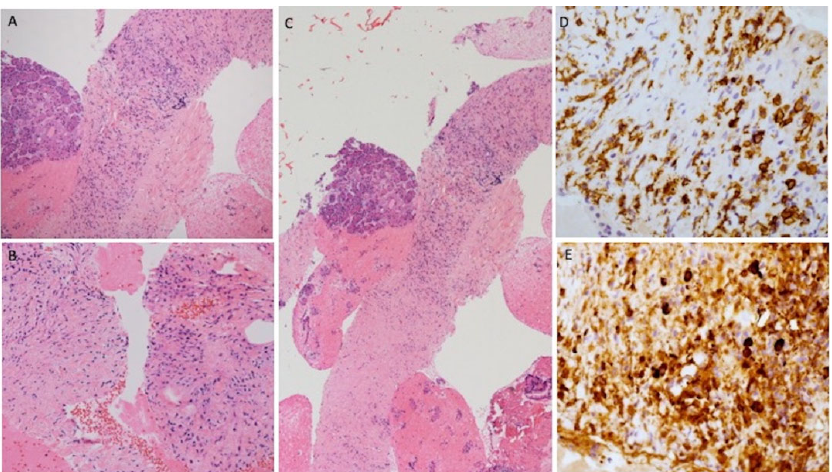
Figure 2. The histological examination demonstrated fragments of sclerotic stroma in storiform fashion, in which inflammation cells (most lymphocyte and plasma cells) were recognizable (( A – C ); Hematoxylin and Eosin stains at different magnifications). Moreover, the immunostaining for CD38 highlighted the plasma cells population ( D ) and immunostaining for IgG4 showed a considerable amount of specific immunoglobulin in diagnostic range for type 1 autoimmune pancreatitis ( E ). The CMFP represents the 10–30% of chronic pancreatitis and the differential diagnosis with pancreatic cancer is very difficult [2]. MRI has a high diagnostic accuracy in the diagnosis of chronic pancreatitis with a sensitivity and specificity, respectively, of 78% and 96% [3]. Gu et al. suggest using 18F-FDG PET/CT combined with CA19–9 to differentially diagnose pancreatic cancer from CMFP [4]. EUS is a very sensitive examination to detect pancreatic masses and can provide useful information in cases where conventional radiologic workup remains inconclusive [5]. Thanks to its high-resolution images, EUS is more precise than MRI and CT for the diagnosis of small pancreatic lesions. However, its specificity remains low (about 50%) since most lesions showed unclear echoic signs. Probably, the association of EUS with contrast enhancement and elastography can increase the overall accuracy [6,7]. Choline plays an important role in the structure and the function of biological membranes and is essential for the synthesis of phospholipids [8]. The distribution of FCH is physiological in the pancreas as in the liver, spleen, salivary, and lacrimal glands [1]. The uptake of choline is also present in many cancers and in the immune cells as macrophages, present in inflammatory processes [9–11]. This is the first case of CMFP detected by FCH. We cannot recommend the use of FCH PET as an alternative diagnostic imaging in autoimmune pancreatic processes, but we strongly suggest careful interpreting PET-imaging (especially in case of focal tracer uptake in the pancreas). Furthermore, images from hybrid PET/MRI scanners [8] should be assessed, since they can provide complete information by using a single